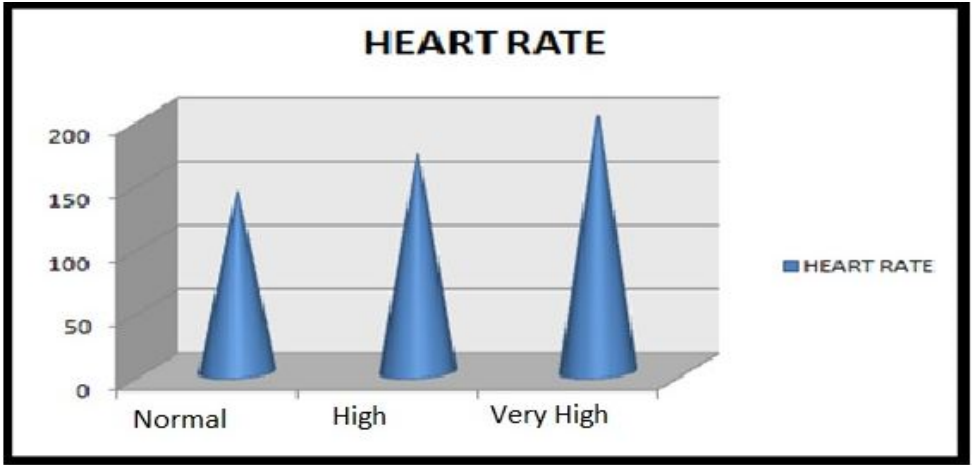
Figure 8. Patients’ heart rate levels.